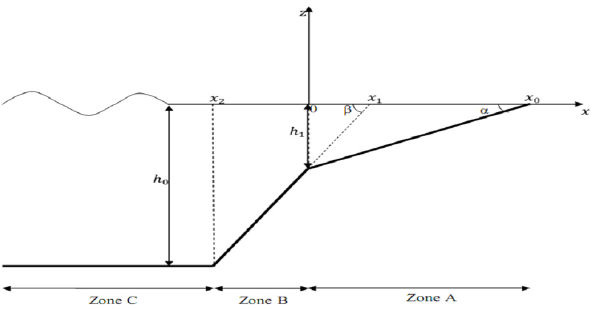
Fig. 1. Schema of bottom